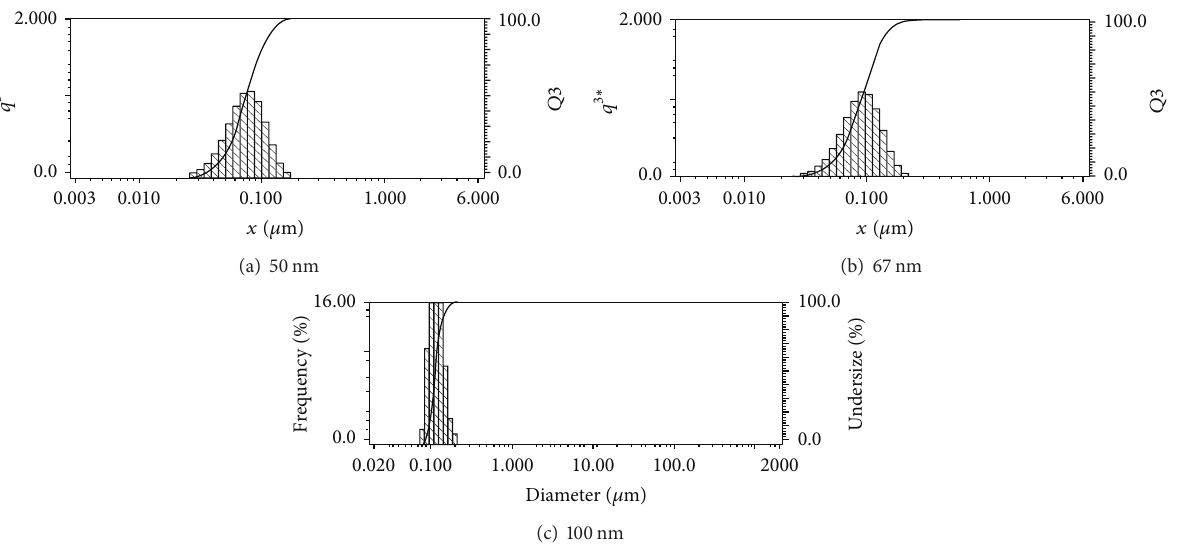
Figure 7: Particle size distribution of nanodiamonds. (a) 50 nm diamonds from 1/20, CKK Co., USA. (b) 70 nm diamonds from 1/15, CKK Co., USA. (c) 100 nm diamond from 1/10, CKK Co., USA.